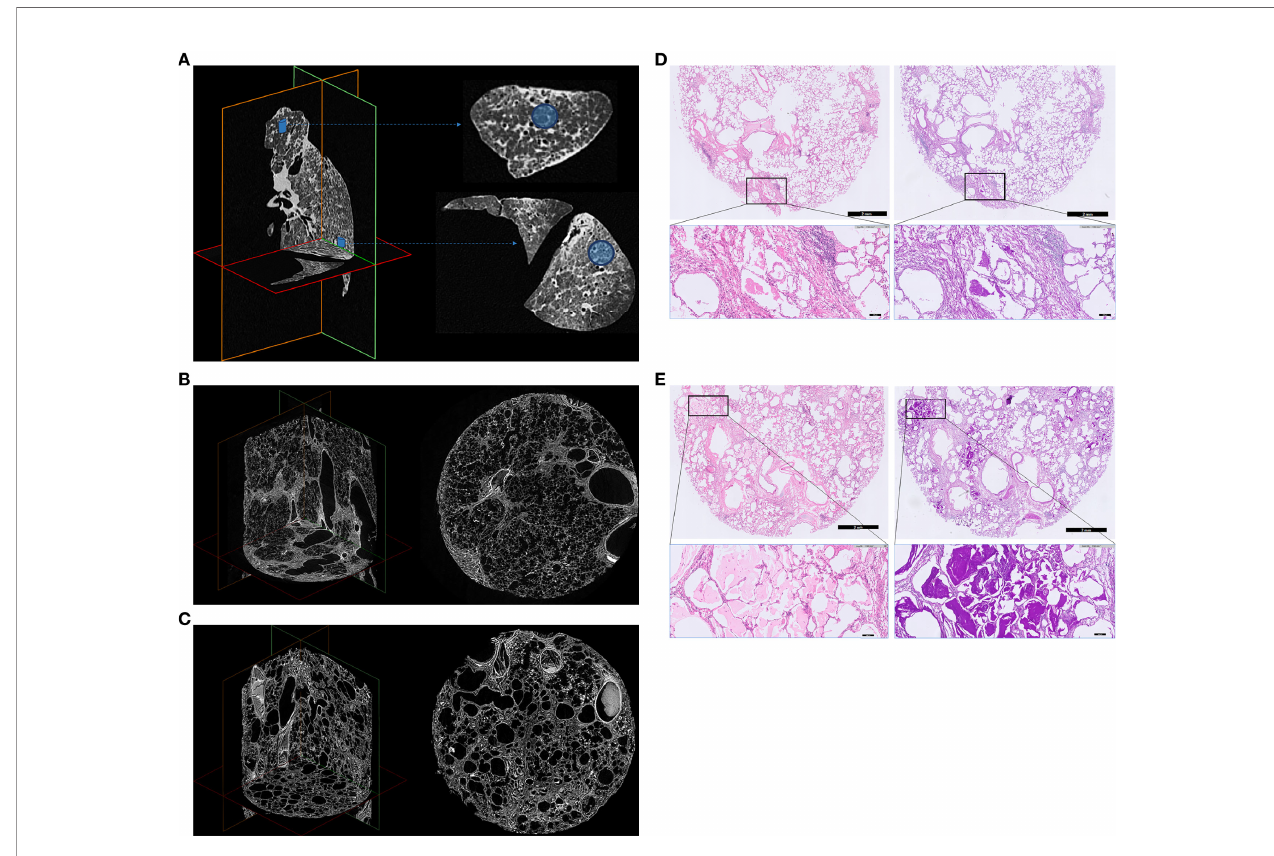
(18, 19). Multidetector CT was obtained using a Siemens Somatom (120 kV, Br59d reconstruction kernel, pixel spacing: 0.7 mm, 1 mm slice thickness) to determine the localization of cores in the lung. Afterwards, the lung was sawed in sections of 2 cm using a bandsaw, and cores of 1.4 cm diameter were taken in the apex and basal part using a hole saw. These lung tissue cores were chemically dried using hexamethyldisilazane (Sigma-Aldrich, USA) and scanned with a Skyscan 1272 microCT scanner (50 kV, 200 µA, voxel size: 8.1 µm, Bruker, Kontich, Belgium). Animated videos of the in vivo CT prior to lung transplantation and the ex vivo CT and micro-CT of the explanted left lung are presented in Supplemental Figure 2 . For histology, tissue cores were routinely formalin- fi xed and paraf fi n embedded. Sections of 5 µm were subsequently stained with Hematoxylin and Eosin (H&E) using an automated H&E platform (CoverStainer, Dako Agilent) and with Periodic Acid Schiff (PAS) using an automated special staining system (Artisan Link Pro Special Staining System, Dako Agilent). Corresponding histological images are shown from upper/lower lobe tissue core: hematoxylin eosin (H&E) staining (left), and Periodic Acid Schiff (PAS) staining after diastase digestion (right) (200x total magni fi cation). The lung parenchyma shows an overt fi brotic remodeled alveolar parenchyma, with thickening of intra- and interlobar septae (reticulation), traction bronchiectasis/bronchiolectasis, honeycombing and prominent fi lling of the alveolar spaces with a granular eosinophilic proteinaceous material, which stains strongly PAS positive. Architectural distortion due to these histologic changes was observed both in the apical and basal lung fi